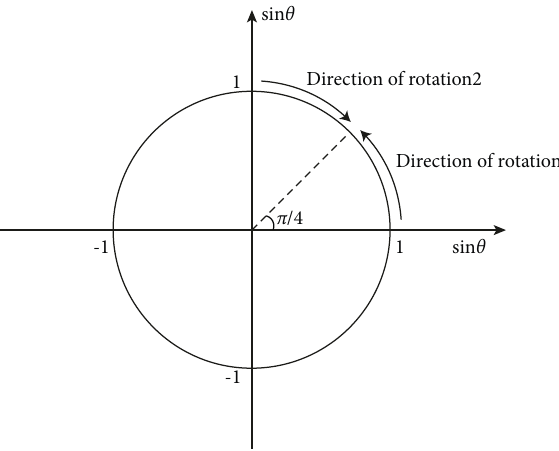
Figure 1: Direction of rotation (early stage of